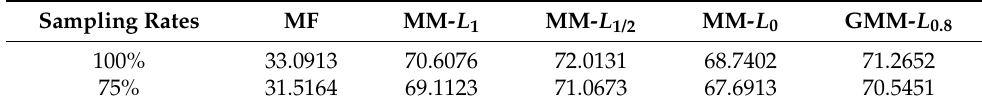
Figure 8. The imaging results of the real ground-based array SAR data corresponding to the 75% sampling rate. ( a ) The MF result. ( b ) The MM- L 1 result. ( c ) The MM- L 1/2 result. ( d ) The MM- L 0 result. ( e ) The GMM- L 0.8 result. Table 5. The TBR of the Ground-Based Array SAR Data.